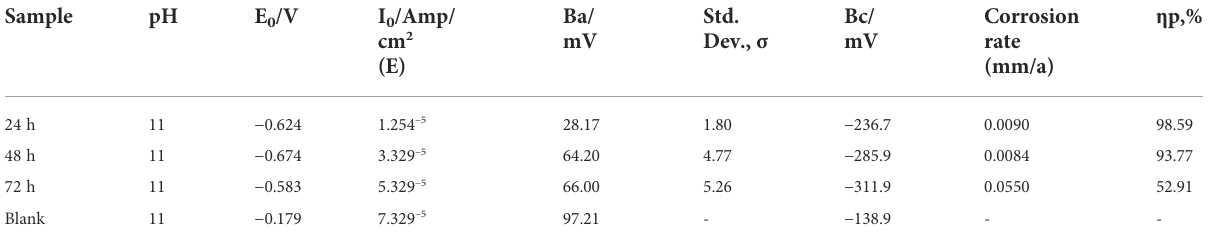
TABLE 3 Comparison of electrochemical measurements for coated and blank Al alloy 6101 samples in the corrosion solution (pH 11). Sample